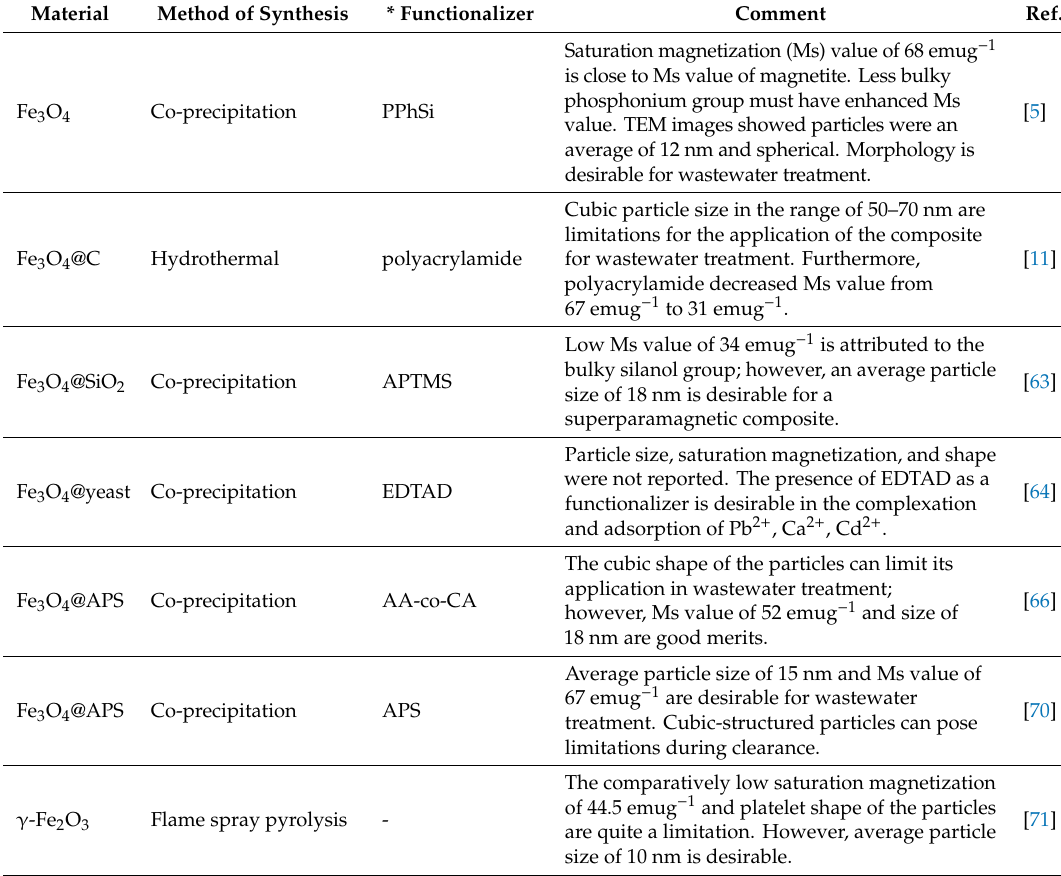
Figure 3. ( a ) Coated and ( b ) functionalized magnetic oxide nanocomposites. Table 2. Synthetic methods for magnetic oxide adsorbents: merits and demerits.